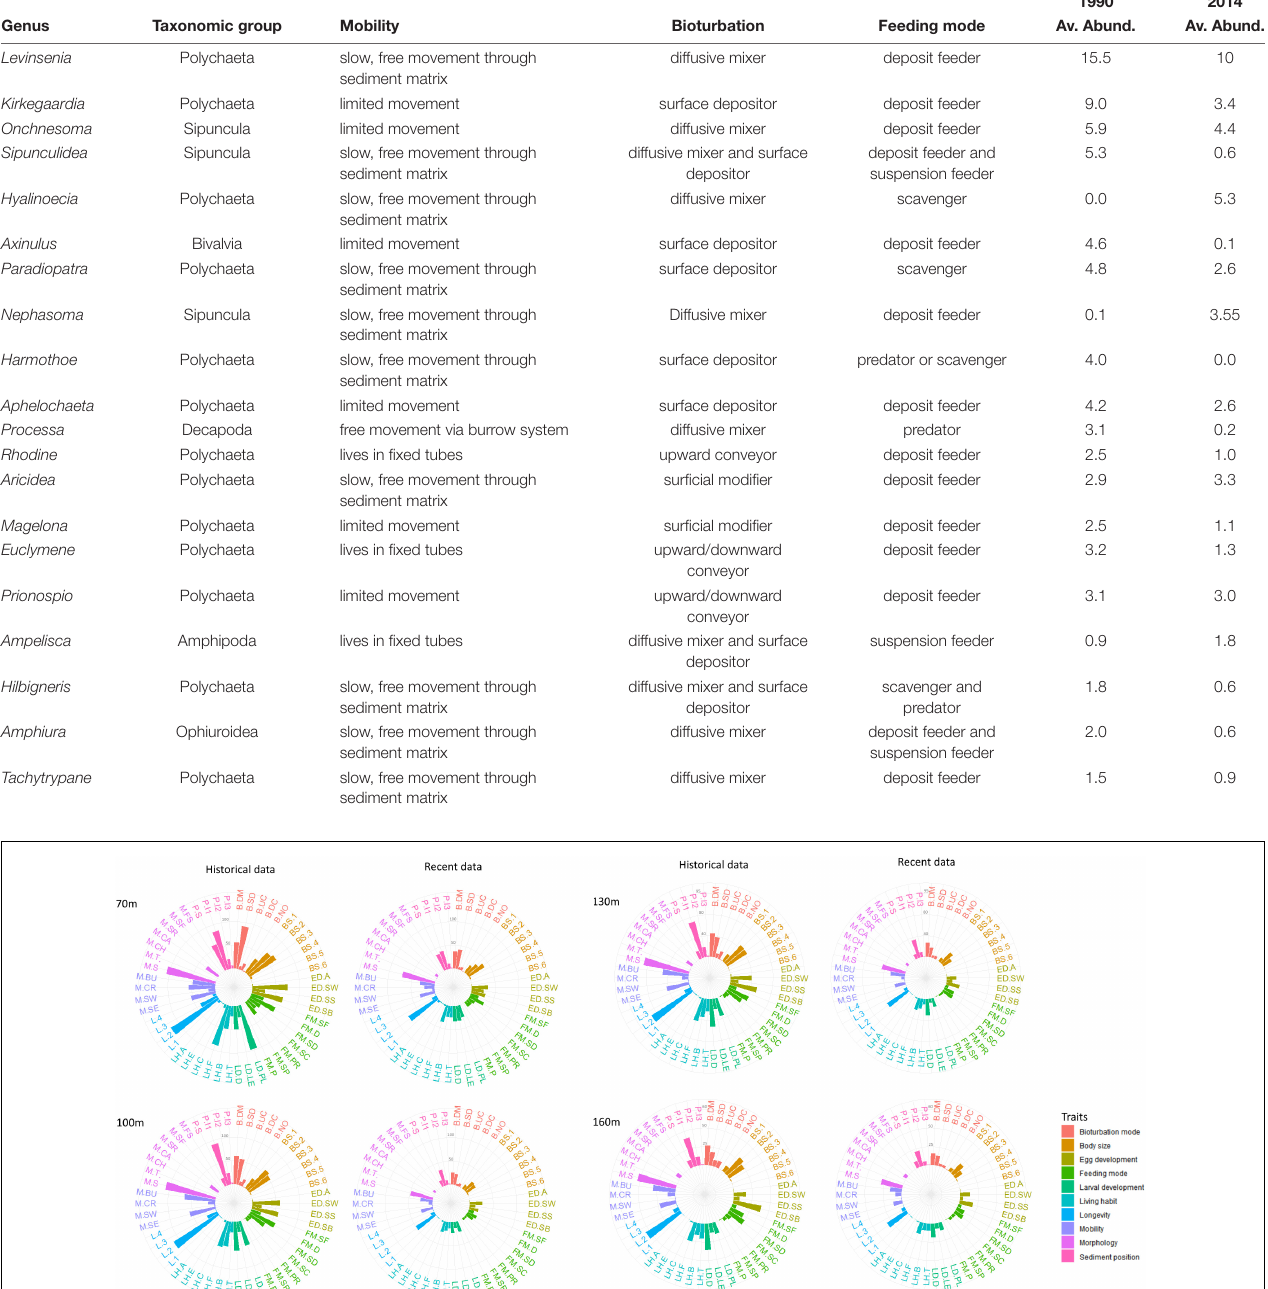
The temporal differences in taxonomic alpha diversity were accompanied by temporal differences in community composition (taxonomic beta diversity). Partitioning of the temporal beta diversity revealed that taxa loss was the dominant pattern in